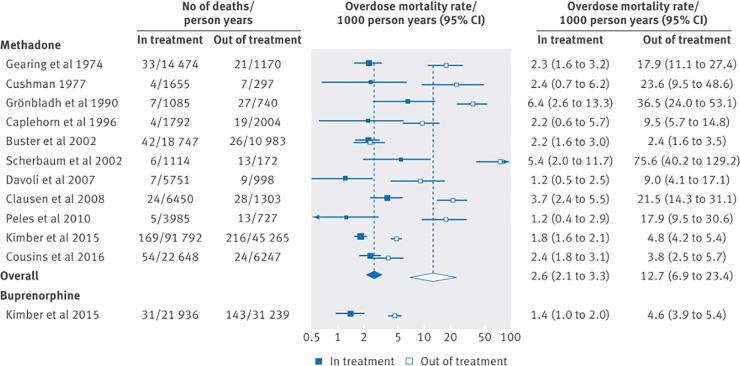
Overdose mortality rates in and out of methadone and buprenorphine treatment (Sordo et al., 2017; creative commons attribution non commercial (CC BY-NC 4.0) license).